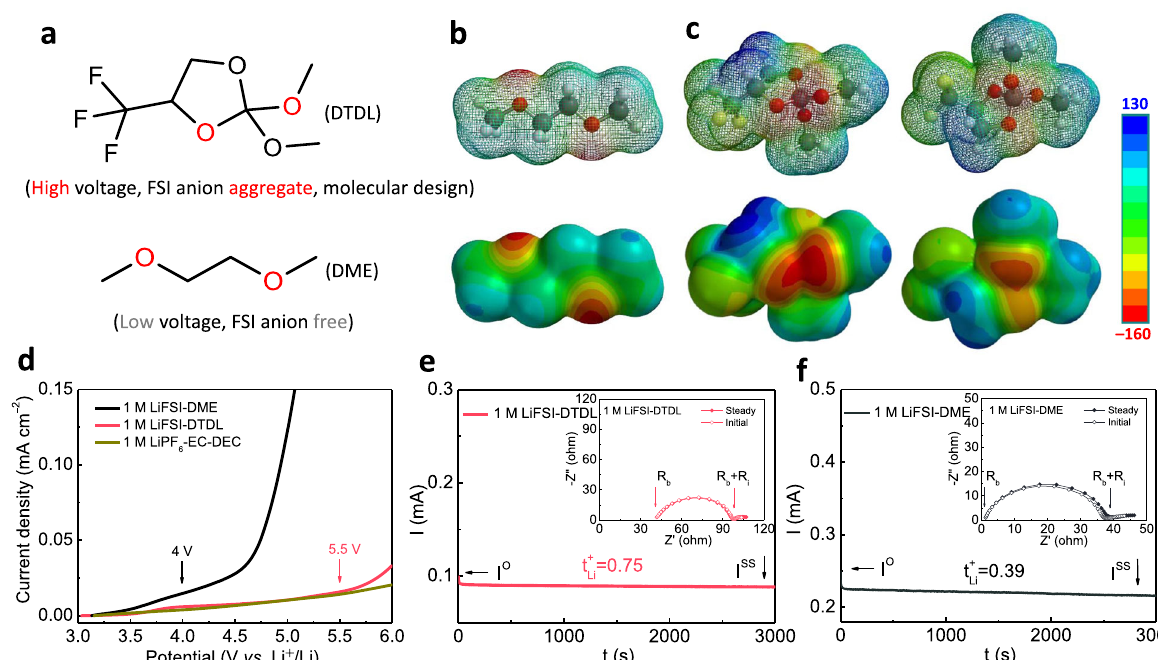
Fig. 1 Molecular structures and electrochemical characterization. a The comparison of molecular structures of DTDL and DME. Electrostatic potential maps (ESP) of DME ( b ) and DTDL with front and back views ( c ), color scheme: yellow, F; red, O; gray, C; white, H. d Oxidation stability of three electrolytes in Li|Al half cells tested by linear sweep voltammetry (LSV). Li + transference numbers and the chronoamperometry pro fi les of Li|Li symmetrical cells in 1 M LiFSI-DTDL ( e ) and 1 M LiFSI-DME ( f ) electrolytes under a polarization voltage of 10 mV. Insets in ( e ) and ( f ): the corresponding electrochemical impedance spectra (EIS) before and after